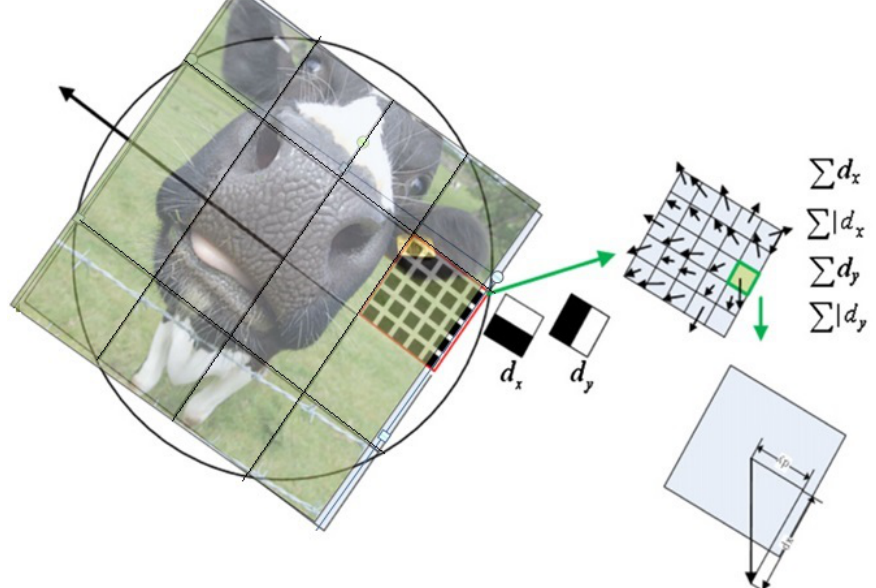
Figure 1. Computing the speeded-up robust features (SURF) descriptor over the gradient space by dividing the square region around points of interest into 4 × 4